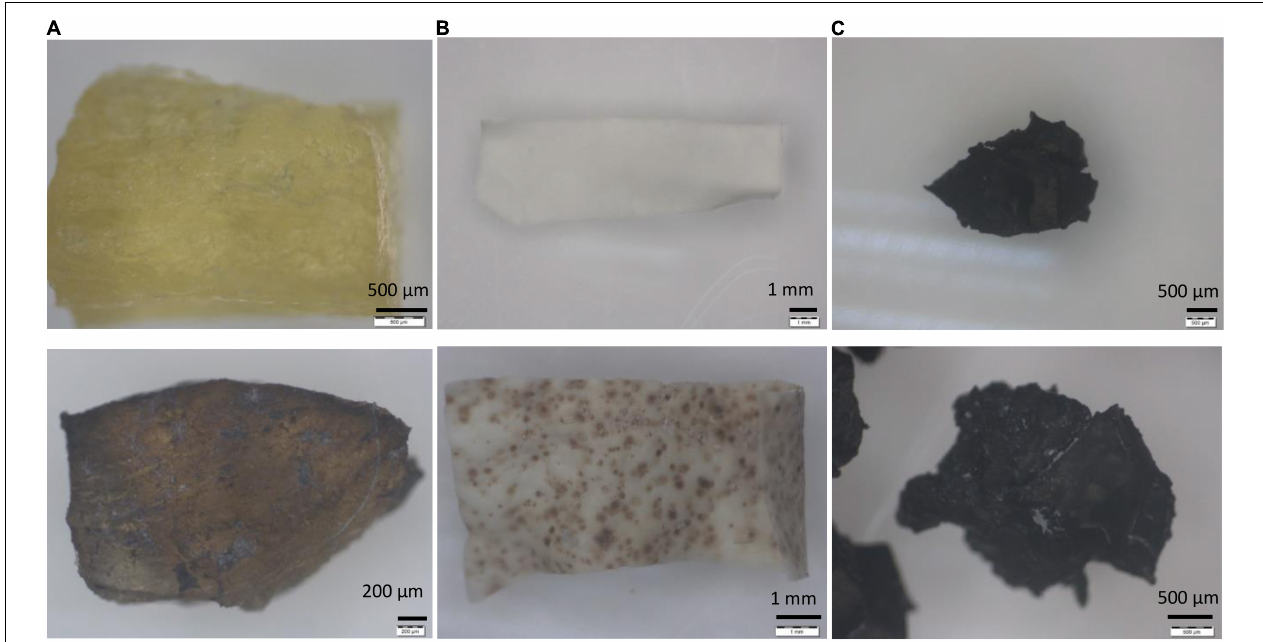
FIGURE 5 | Rubber utilization studies for Streptomyces sp. AC04842 cultivate in MSM broth for 60 days at 28 ◦ C and 180 rpm, before (top row) and after 60 days (bottom rows). (A) Fresh latex pieces, (B) latex glove strips, and (C) tire granules. Samples were removed from the media, rinsed with 96% ethanol, followed by sterile water, and then left to air-dry. Images with 6.7–40 × magnification were taken using a stereo light microscope (Olympus